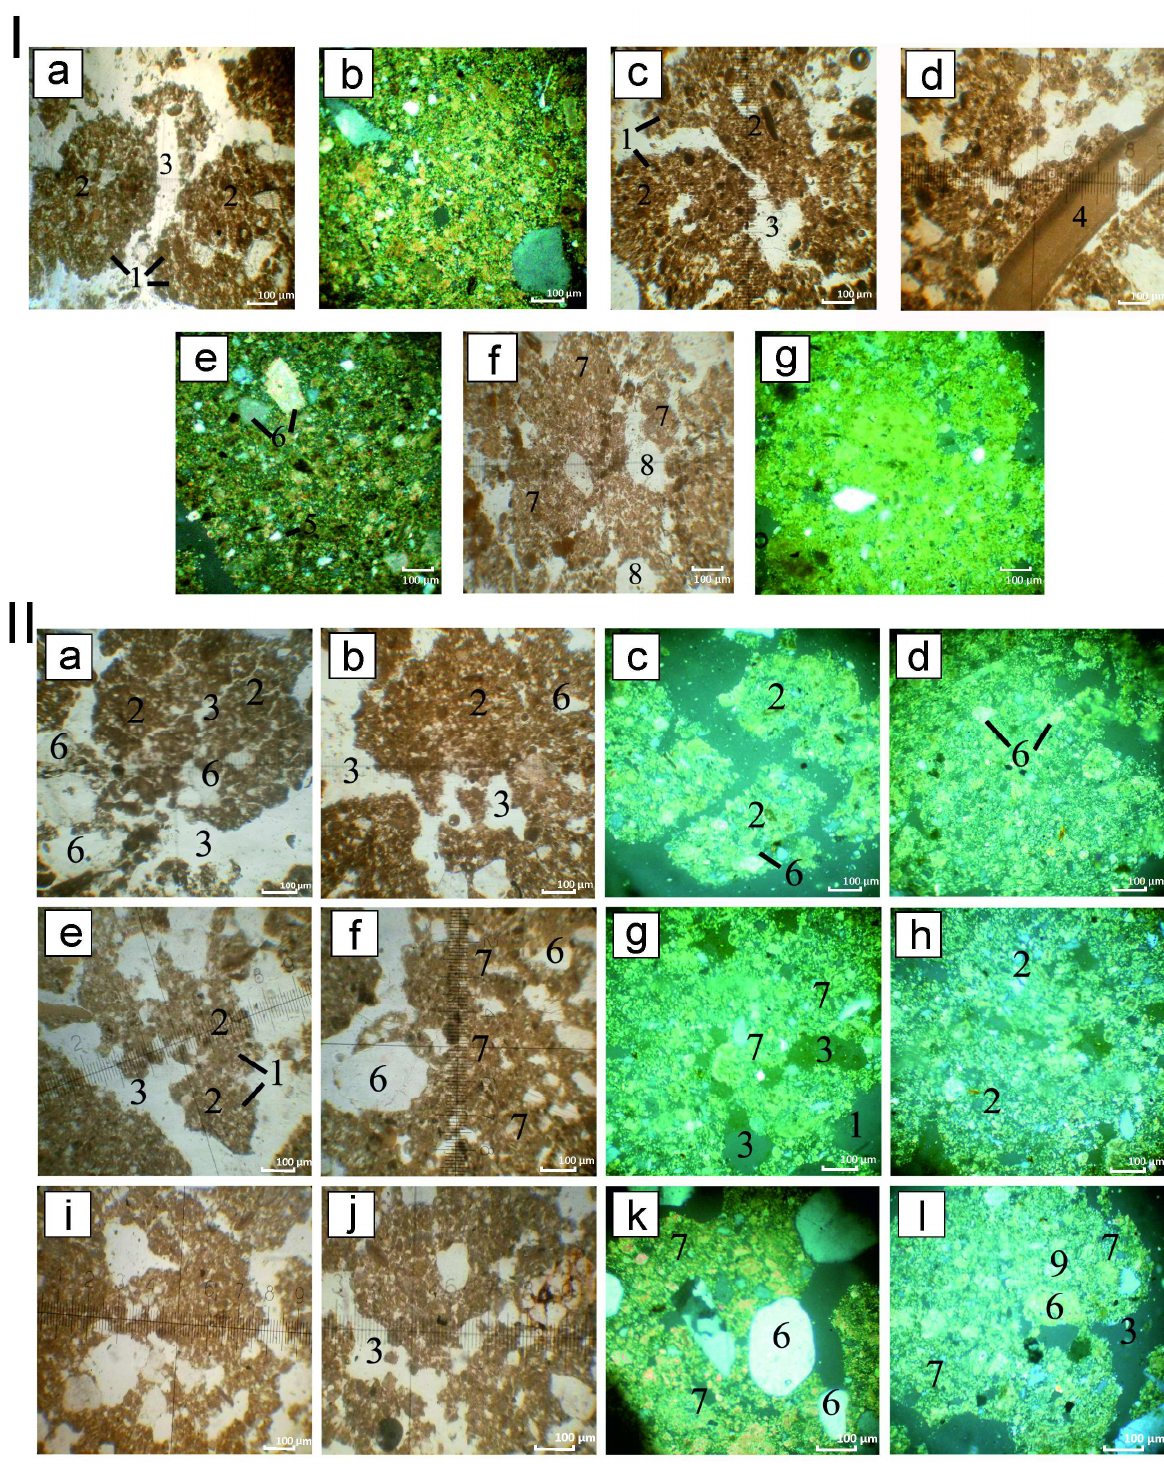
Figure 11. Melnychna Krucha. Micromorphology of soils in the section 1. I—upper soil, ( a , c , d , f )— PPL; ( b , e , g )—XPL. II—middle soil: Captions: see Supplementary Table S1. Left column: soil horizons’ indices; central column: schematic drawing; right column: photos of the actual soil textures from the respective horizons of the section. ( a , b , e , f , i , j )—PPL, ( c , d , g , h , k , l )—XPL. Magnification 1:70. Elaboration—ZM.